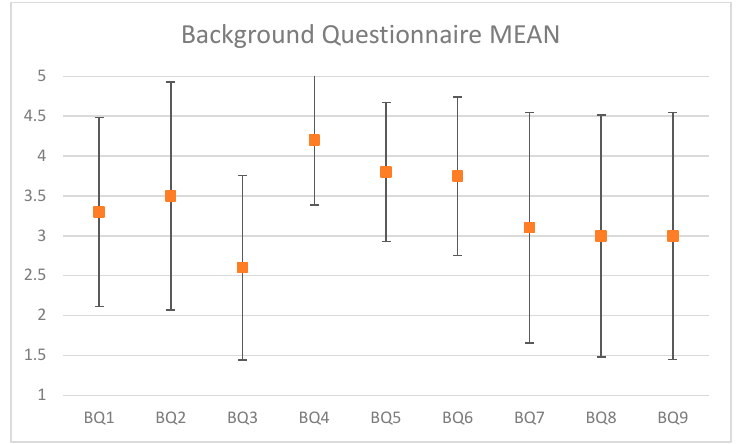
Figure 12. Background questionnaire results: mean and confidence interval (alpha = 0.05).